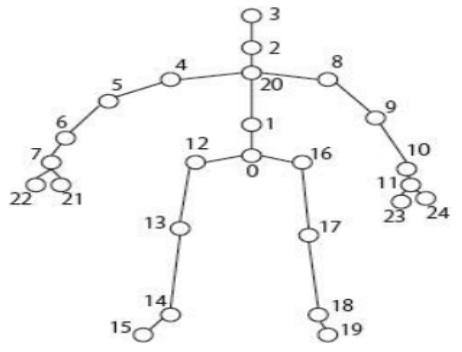
Fig. 1. Kinect human skeleton model and joint points.